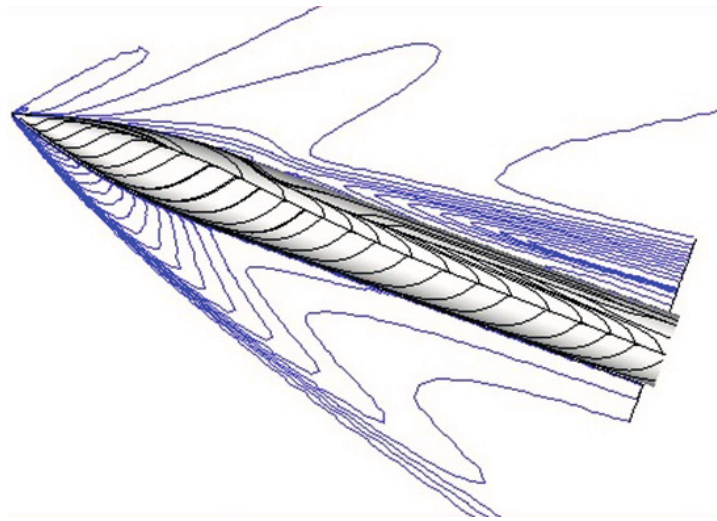
Figure 11. Surface streamlines and density contours for ogive cylinder in supersonic